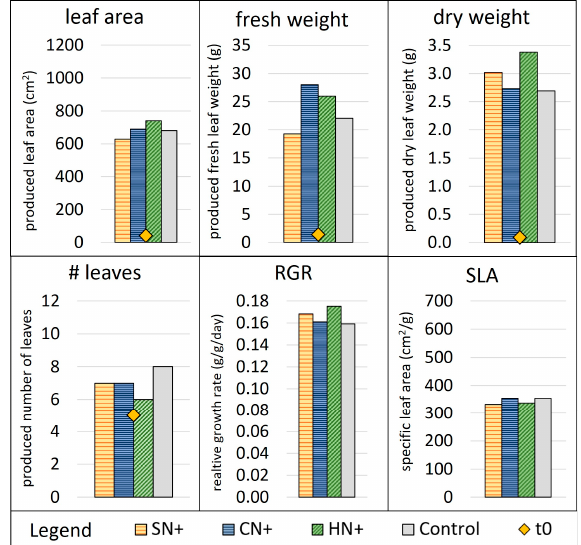
Figure 6. Plant growth parameters in week 3 of cycle 2. Number of leaves, leaf area, fresh and dry weight at t0 are indicated as yellow dots while the additionally produced quantities after 21 days are indicated as bars. Abbreviations: RGR, relative growth rate; SLA, specific leaf area. Reference for MgP salts: H, hazenite. Reference for acids: C, citric acid; N, nitric acid. +, supplemented with KNO 3 .